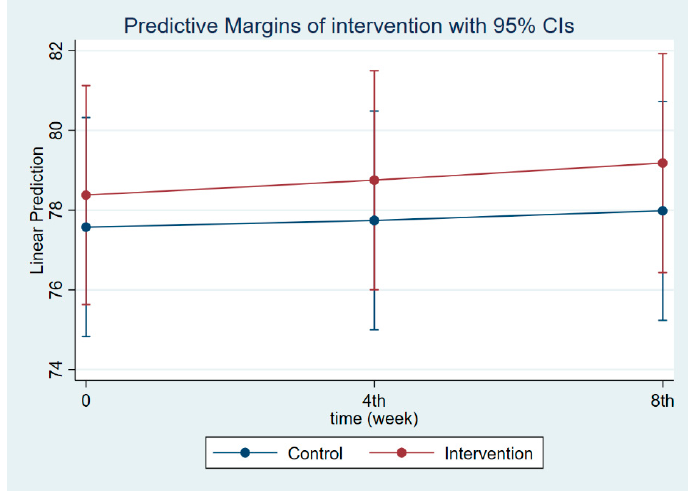
Figure 9. Children’s body height at follow-ups 1 and 2.